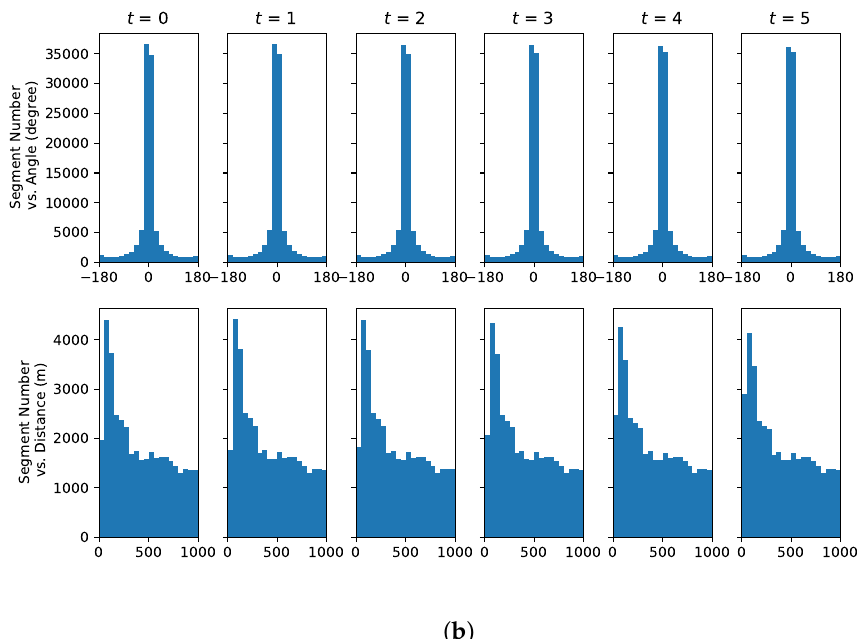
Figure 3. Histograms of distances and angles for trajectory segments with different confidences. Representative segments are those with high confidences, while common segments are those with low confidences. t = 0,1,2,3,4,5 are time units of one